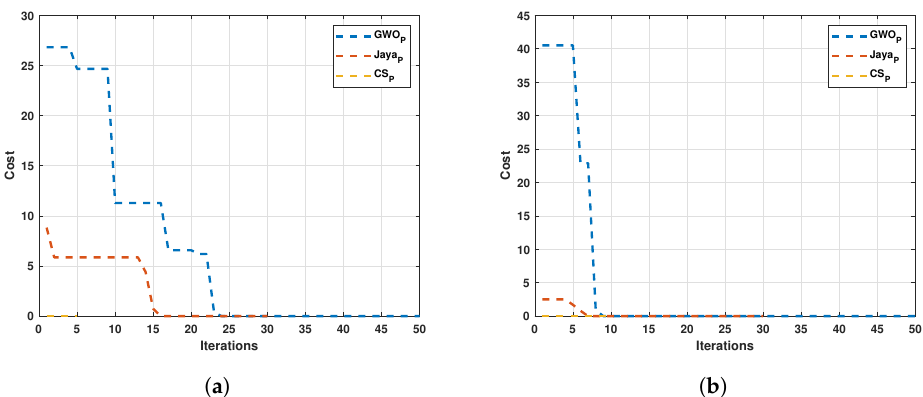
Figure 12. Comparison between the three modified algorithms. ( a ) Tests for Motor 1; ( b ) Tests for Motor 1.